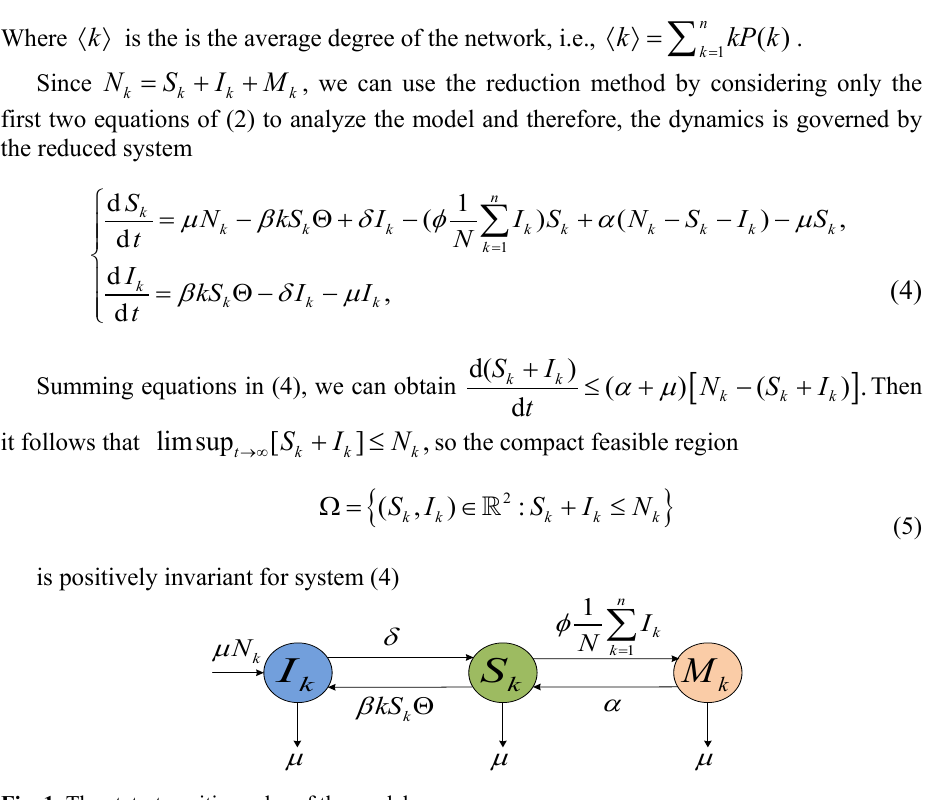
Fig. 1. The state-transition rules of the